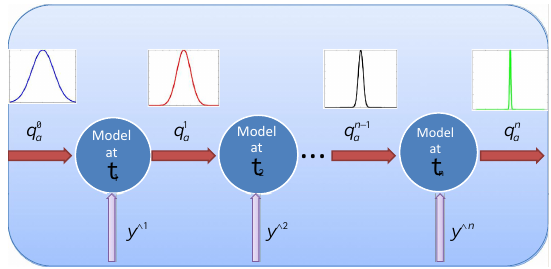
Figure 1. Sequential GMKF